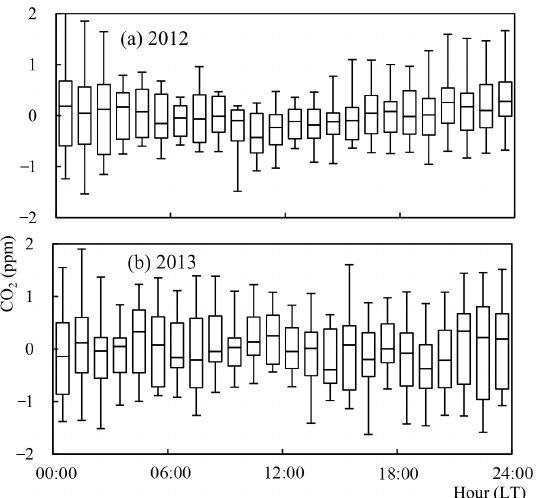
Figure 6. Difference between hourly average and daily average CO 2 concentration during the observed periods: (a) 2012 and (b) 2013. Median value (the line in the box), inner 50th percentile of the value (box), and inner 95th percentile of the value from the daily average for each hour of the day for the CO 2 mixing ratio at Mt. Fuji.